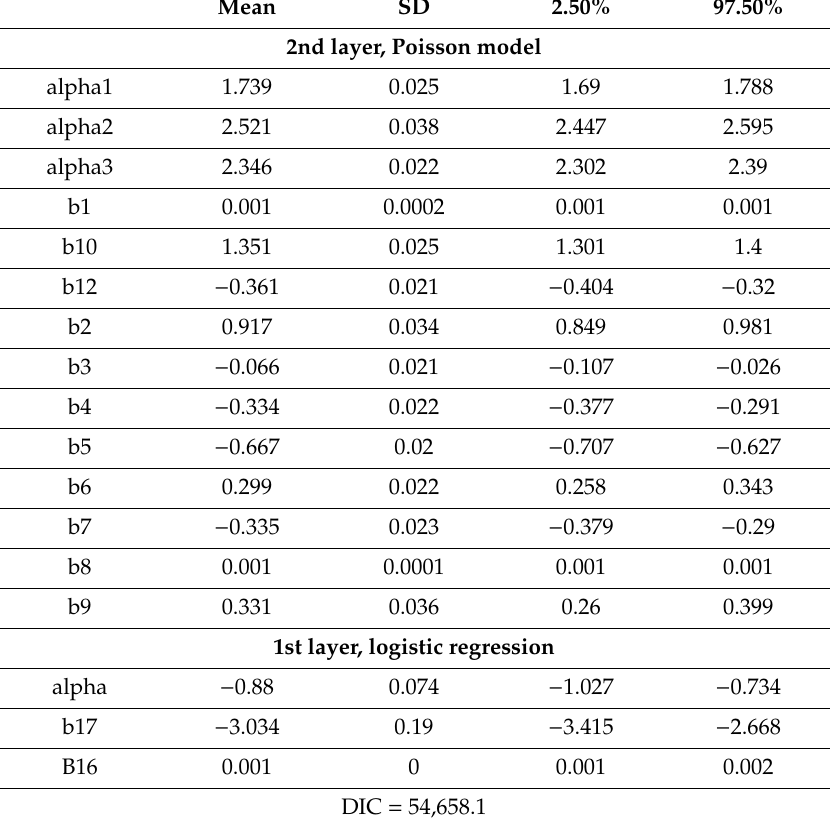
Table 3. Estimation results of two-layer model, with Poisson distribution for the second layer.